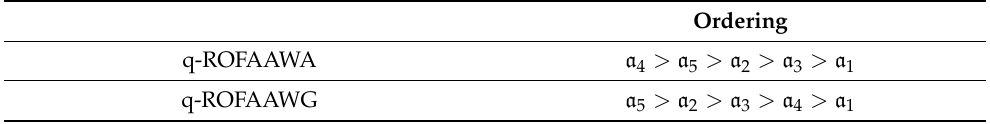
Table 5. Ranking of the score function.